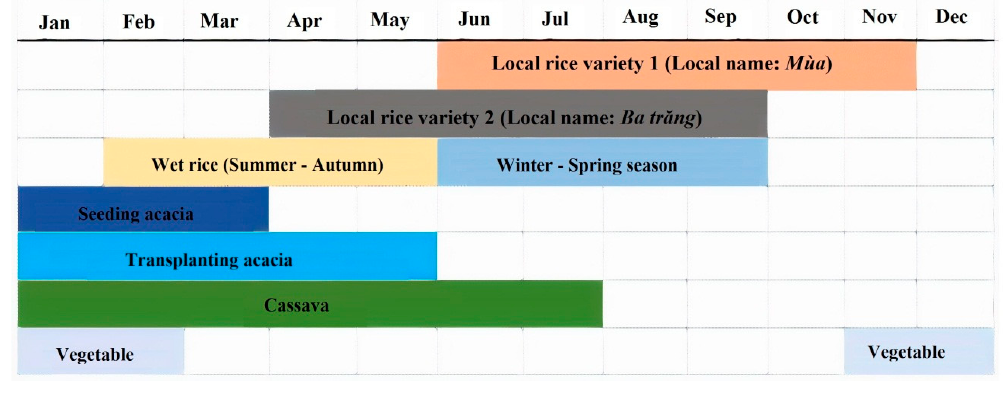
Figure 7. Adjusting the seasonal calendar. Table 6. Social-economic background of